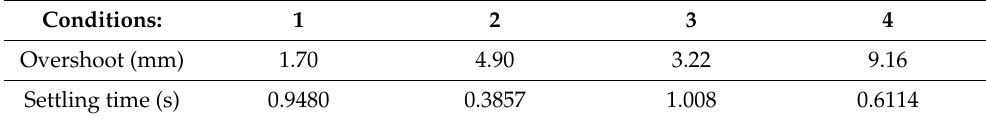
Table 5. Overshoot and settling time under each condition for